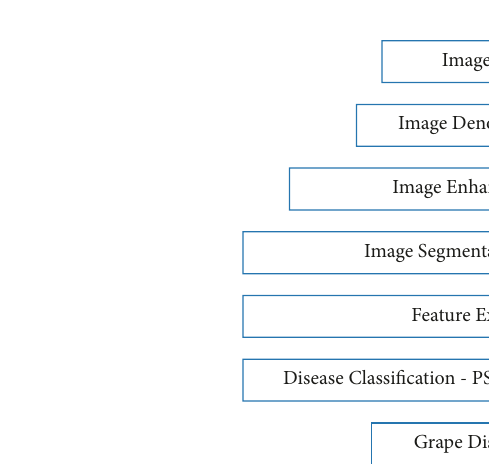
Figure 1: Images of grape leaf disease [8].